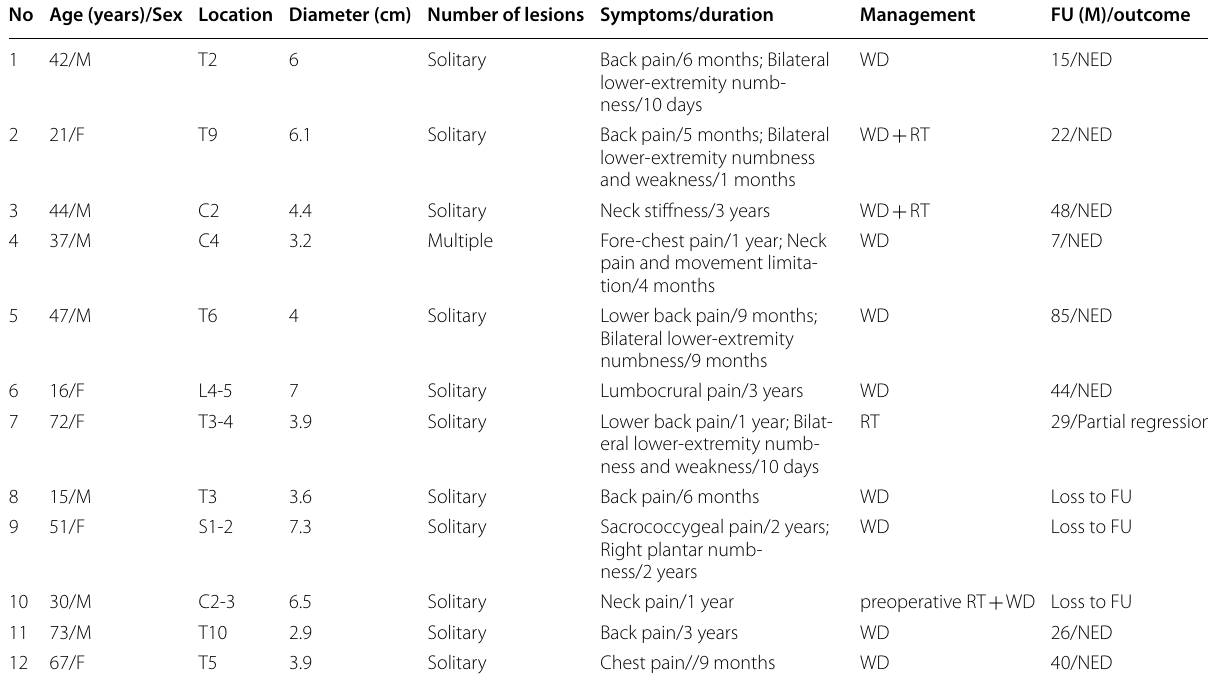
EHE: epithelioid hemangioendothelioma; M: male; F: female; C: cervical; T: thoracic; L: lumbar; S: sacra; RT: radiation therapy; WS: wide surgery; FU: follow-up; NED: no evidence of disease